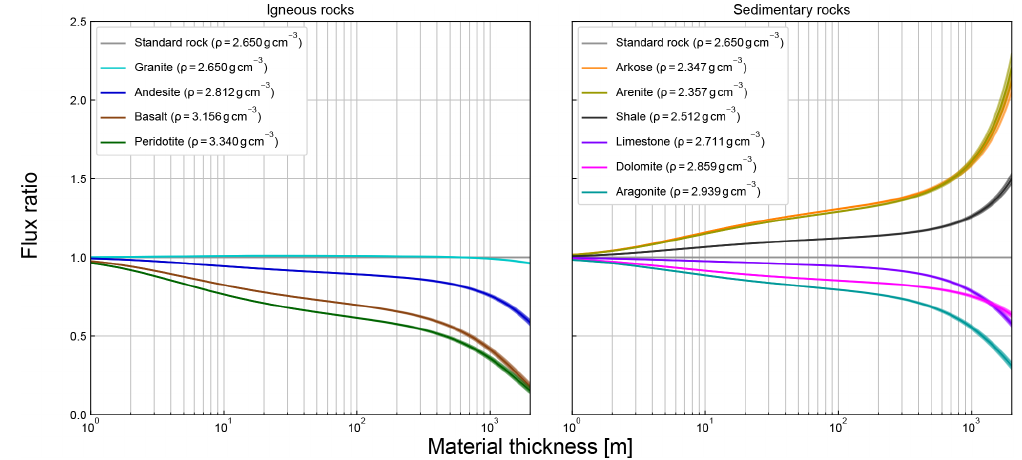
Figure 4. Ratio of the calculated rock fluxes to a standard rock ( ρ SR = 2650gcm − 3 ) muon flux for the rocks reported in Table 1 as a function of rock thickness.